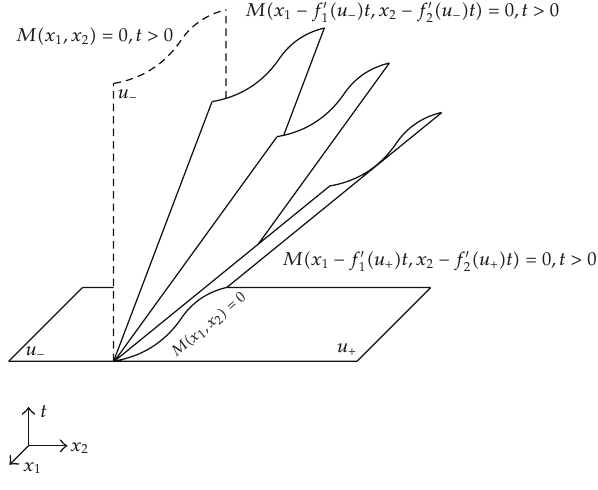
Figure 3: The rarefaction wave solution of Case